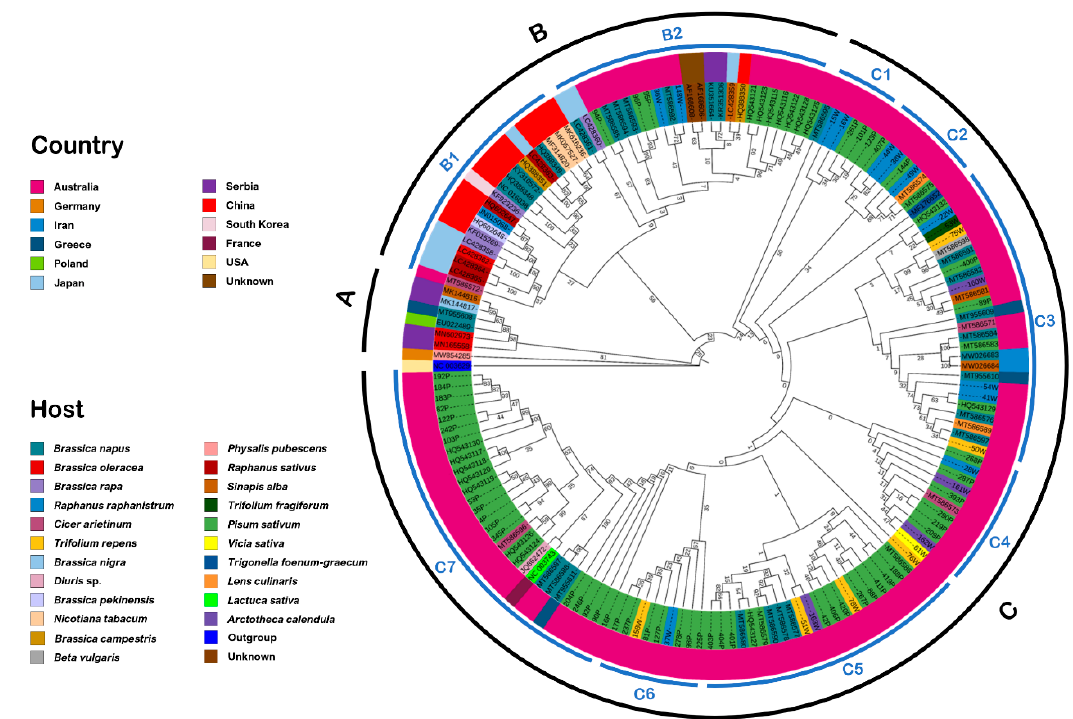
Figure 2. Phylogenetic analysis (maximum likelihood algorithm) based on nucleotide sequences of P0 of Tasmanian isolates. The phylogenetic trees show the evolutionary relationship of P0 of Tasmanian isolates with P0 of worldwide reported TuYV and BrYV isolates. The inner ring indicates the host, and the outer ring the country of origin.